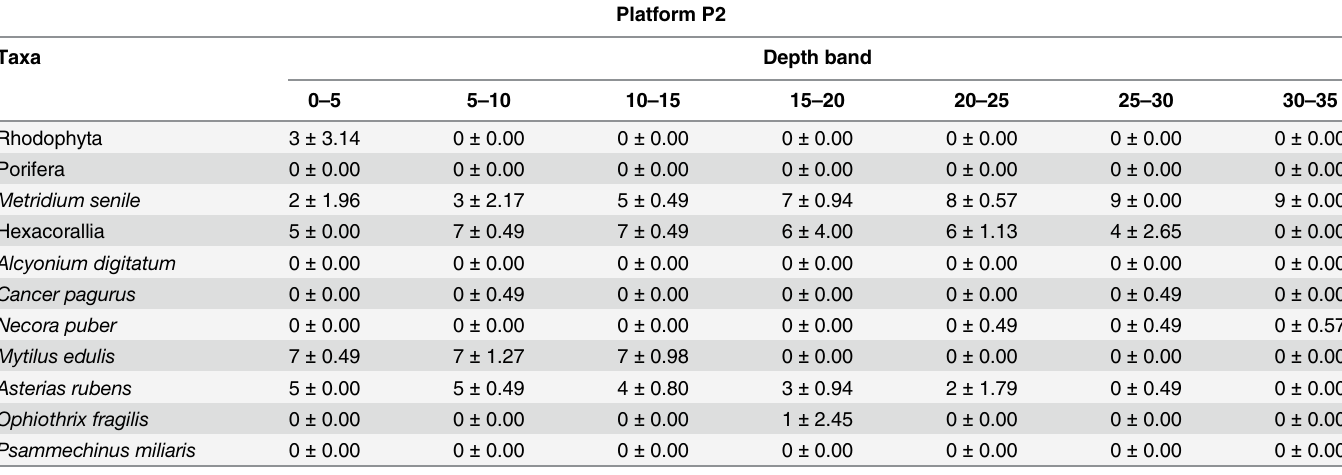
Table 5. Averaged categorised abundance of the 11 high detectable taxa, with 95% confidence interval around the mean, per depth band on plat- form